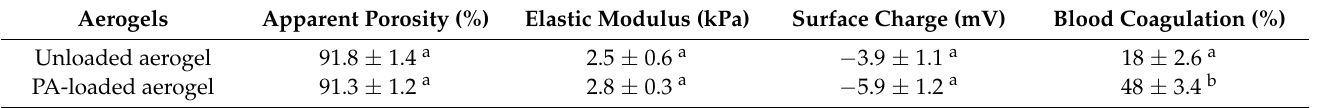
Table 3. Physicochemical and mechanical properties of